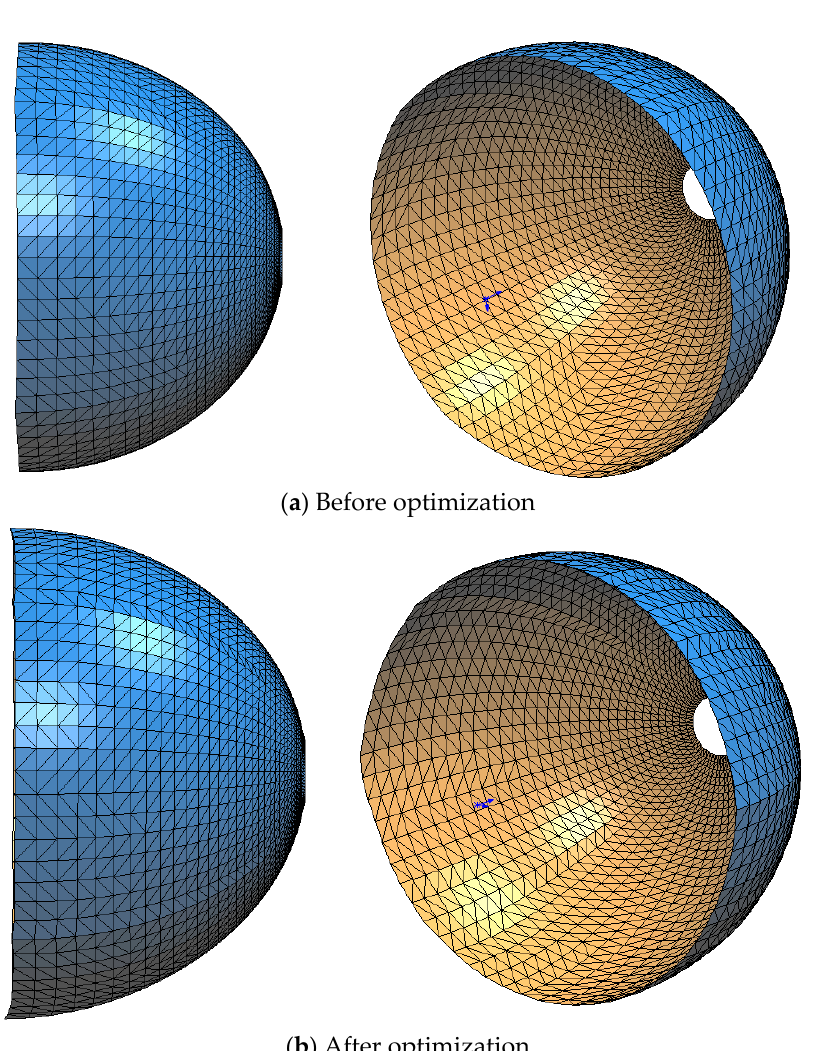
Figure 9. The value of the merit function with iterations.